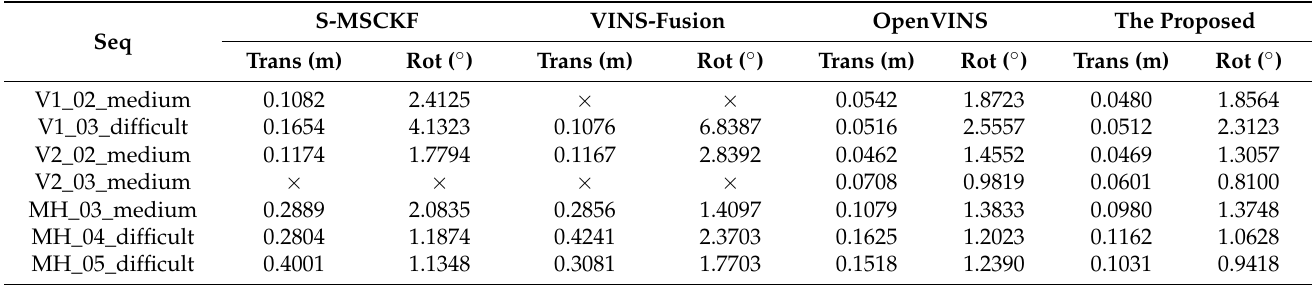
Table 3. The Root Mean Square Error (RMSE) results of OpenVINS and the proposed algorithm.